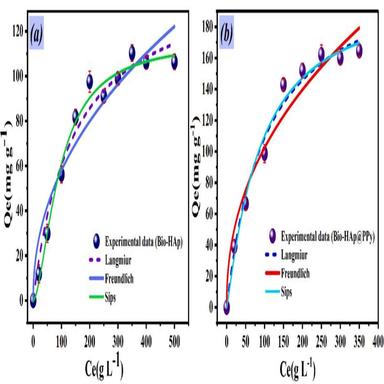
Non-linear isotherm plot for Bio-HAp (a) and Bio-HAp@PPy nanocomposite (b).